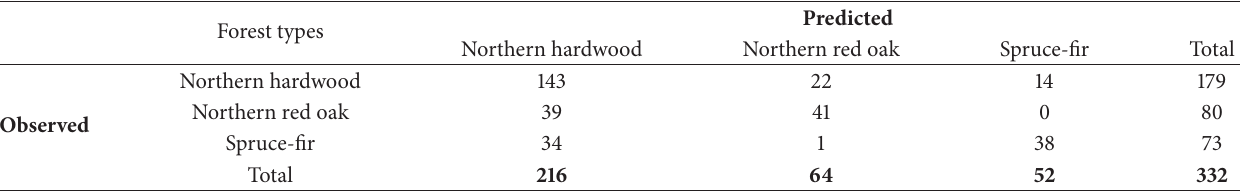
Table 4: Confusion matrix for our best approximating model (Elevation + TEI) showing predicted versus observed forest types for sample points in areas above 1219.2.2 m in elevation of western North Carolina, eastern Tennessee, and southwest Virginia which composed our study area ( 𝑛 = 332 ). Sampling took place between June 2012 and January 2013. Overall accuracy for the prediction of all three forest types was 67% and for the northern hardwood forest type